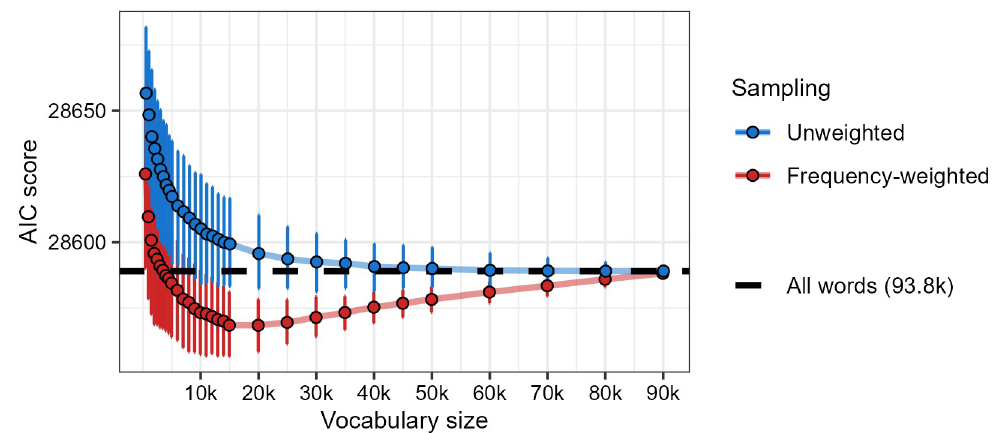
Fig 3. Word-based Monte Carlo analysis of results from Experiment 2, based on 1,000 samples for each vocabulary size. Lower AIC score indicates greater ability to predict participants’ wellformedness judgments. The black dashed line shows the AIC score of a model that assumes phonotactic knowledge generated from the full set of 93,777 words from SUBTLEX-ESP. Points represent mean AIC scores and error bars represent 95% bootstrap percentile intervals.